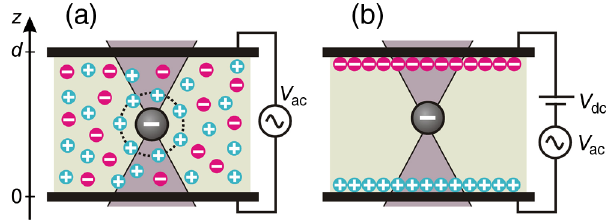
FIG. 1. (a) Schematic representation of a colloidal particle optically trapped at the midplane between two electrodes. The electrophoretic mobility is measured by applying an ac voltage V ac . In (b) the positively and negatively charged reverse micelles are completely or partially separated depending on the magni- tude of the additional dc voltage V dc .